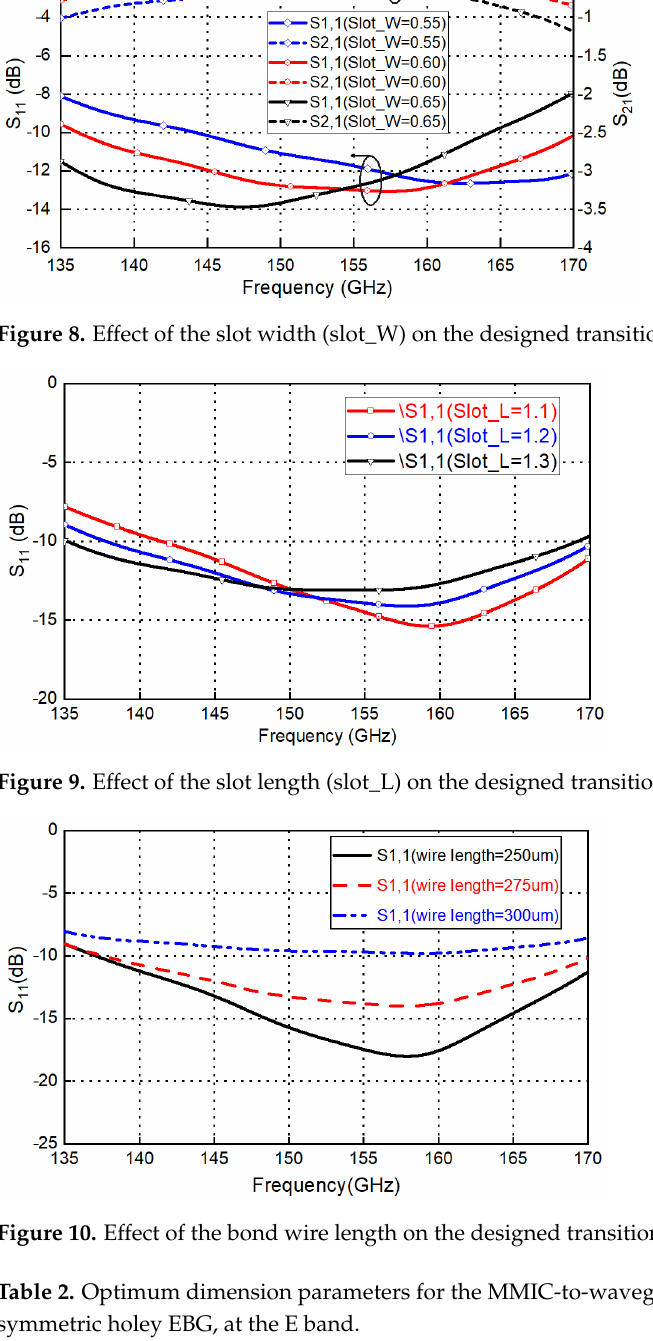
Table 2. Optimum dimension parameters for the MMIC-to-waveguide transition, based on a glide- symmetric holey EBG, at the E band.